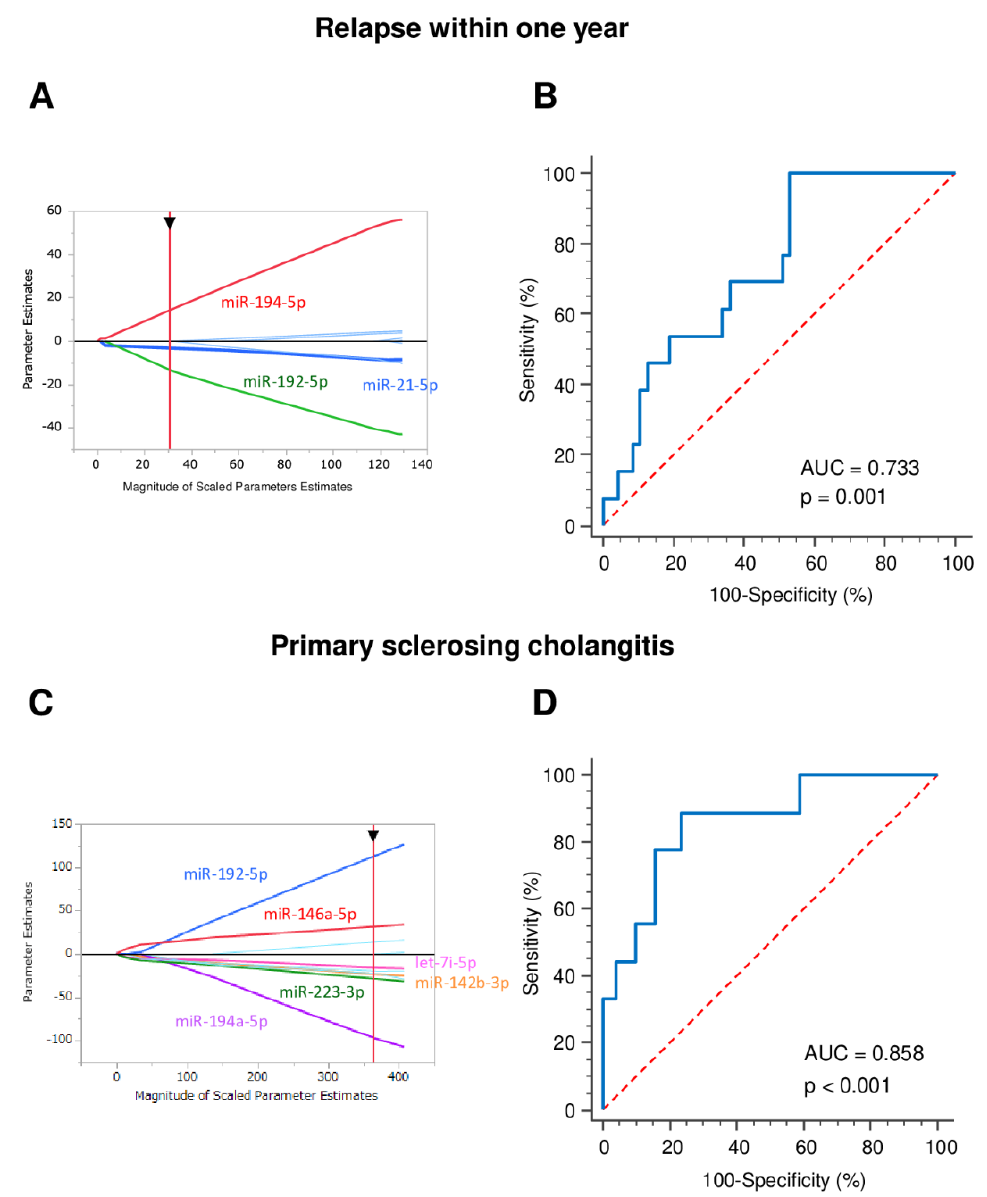
Figure 4. Diagnostic accuracy of miRNAs for identifying relapse within 1 year and primary sclerosing cholangitis. ( A ) Adaptive LASSO model; ( B ) ROC curves for detecting early relapse in UC patients using 3-miRNA panel. Logit (risk score) = 1.26 − 4.44 × miR-21-5p − 15.83 × miR-192-5p + 17.60 × miR-194-5p; ( C ) Adaptive LASSO model was applied to the qPCR data; ( D ) ROC curves for detecting primary sclerosing cholangitis in UC patients using 6-miRNA panel. Logit (risk score) = − 0.24 − 5.43 × miR-142-3p + 13.00 × miR-146a-5p + 14.59 × miR-192-5p − 19.57 × miR-194-5p − 5.23 × miR-223-3p − 14.42 × let-7i-5p.